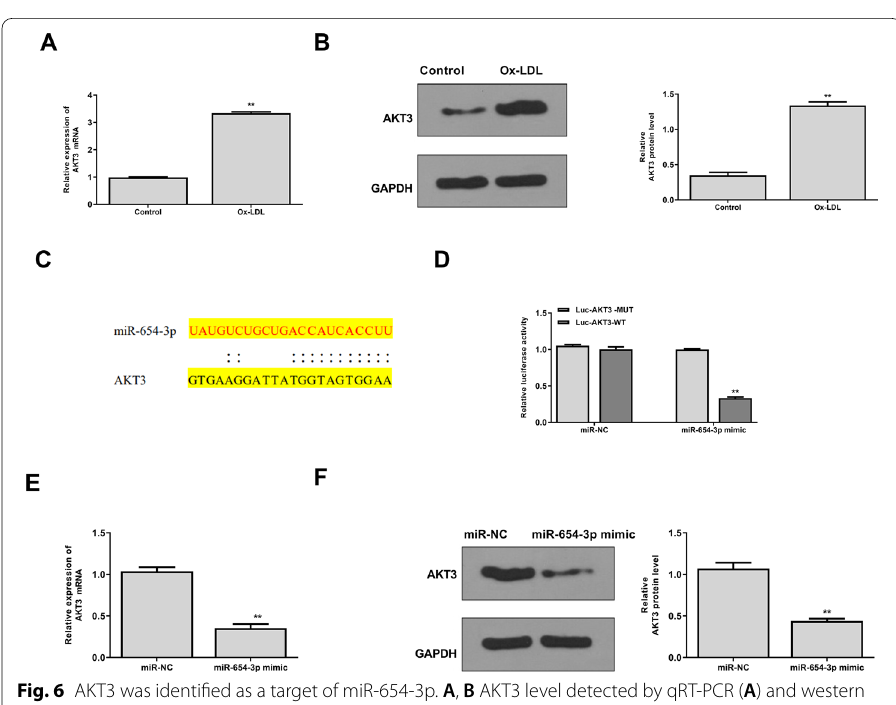
Fig. 6 AKT3 was identified as a target of miR-654-3p. A , B AKT3 level detected by qRT-PCR ( A ) and western blot ( B ) in HAECs were treated with or without 50 μg/ml Ox-LDL for 24 h. C The putative binding site between miR-654-3p and AKT3 predicted by StarBase. D Results of dual luciferase reporter assay. E , F AKT level detected by qRT-PCR ( E ) and Western blot ( F ) in HAECs transfected with miR-654-3p mimics or miR-NC. **P <